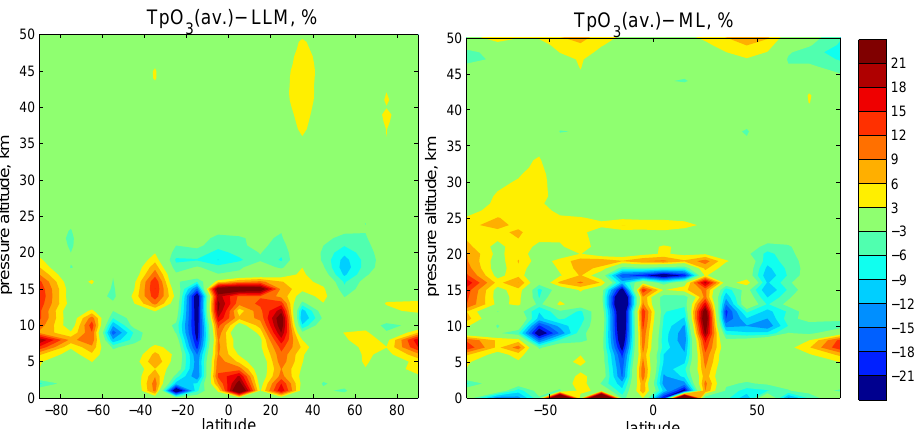
Fig. 10. Percent difference in annual ozone as a function of latitude and altitude between the downgraded (monthly average) TpO 3 climatol- ogy and LLM (left) and ML (right) climatologies.